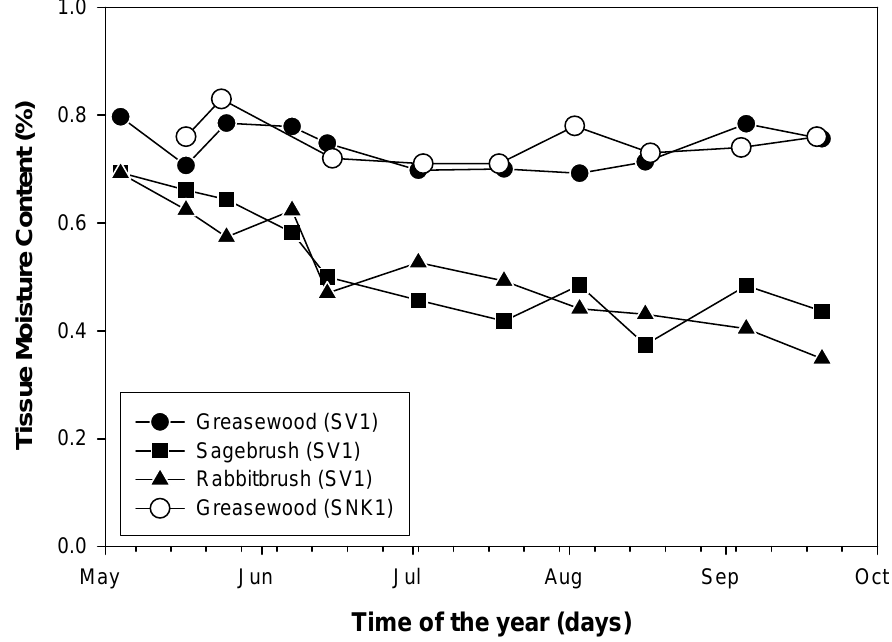
Figure 7. Leaf moisture content for greasewood, sagebrush and